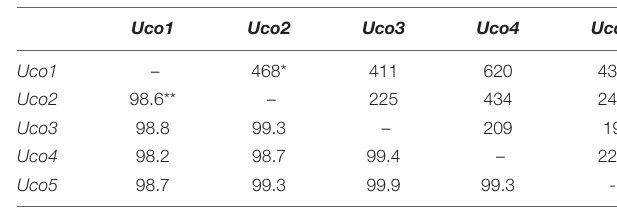
TABLE 4 | Differences (bp, upper-right) and identity values (%, bottom-left) of the aligned nucleotide sequences of 61 genes included 29 core PCGs, 2 rRNAs, 27 tRNAs and 3 cfORFs in the five mitogenomes of U. compressa